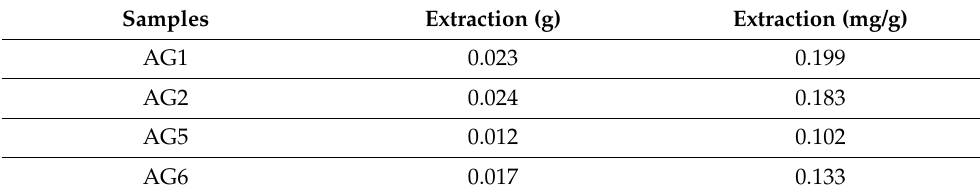
Table 2. Results of Soxhlet extraction for the four rich selected samples of Kastos Island. Samples